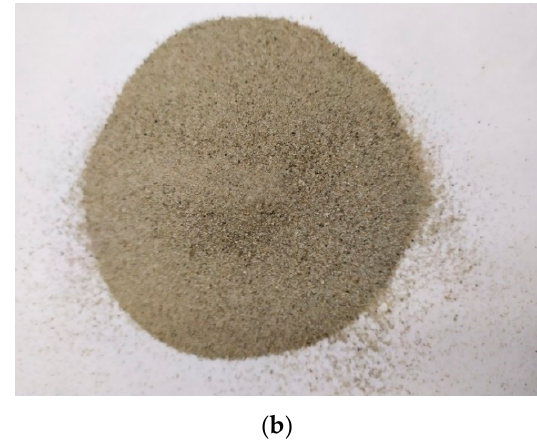
Figure 1. ( a ) Fly ash; ( b ) Microspheres.